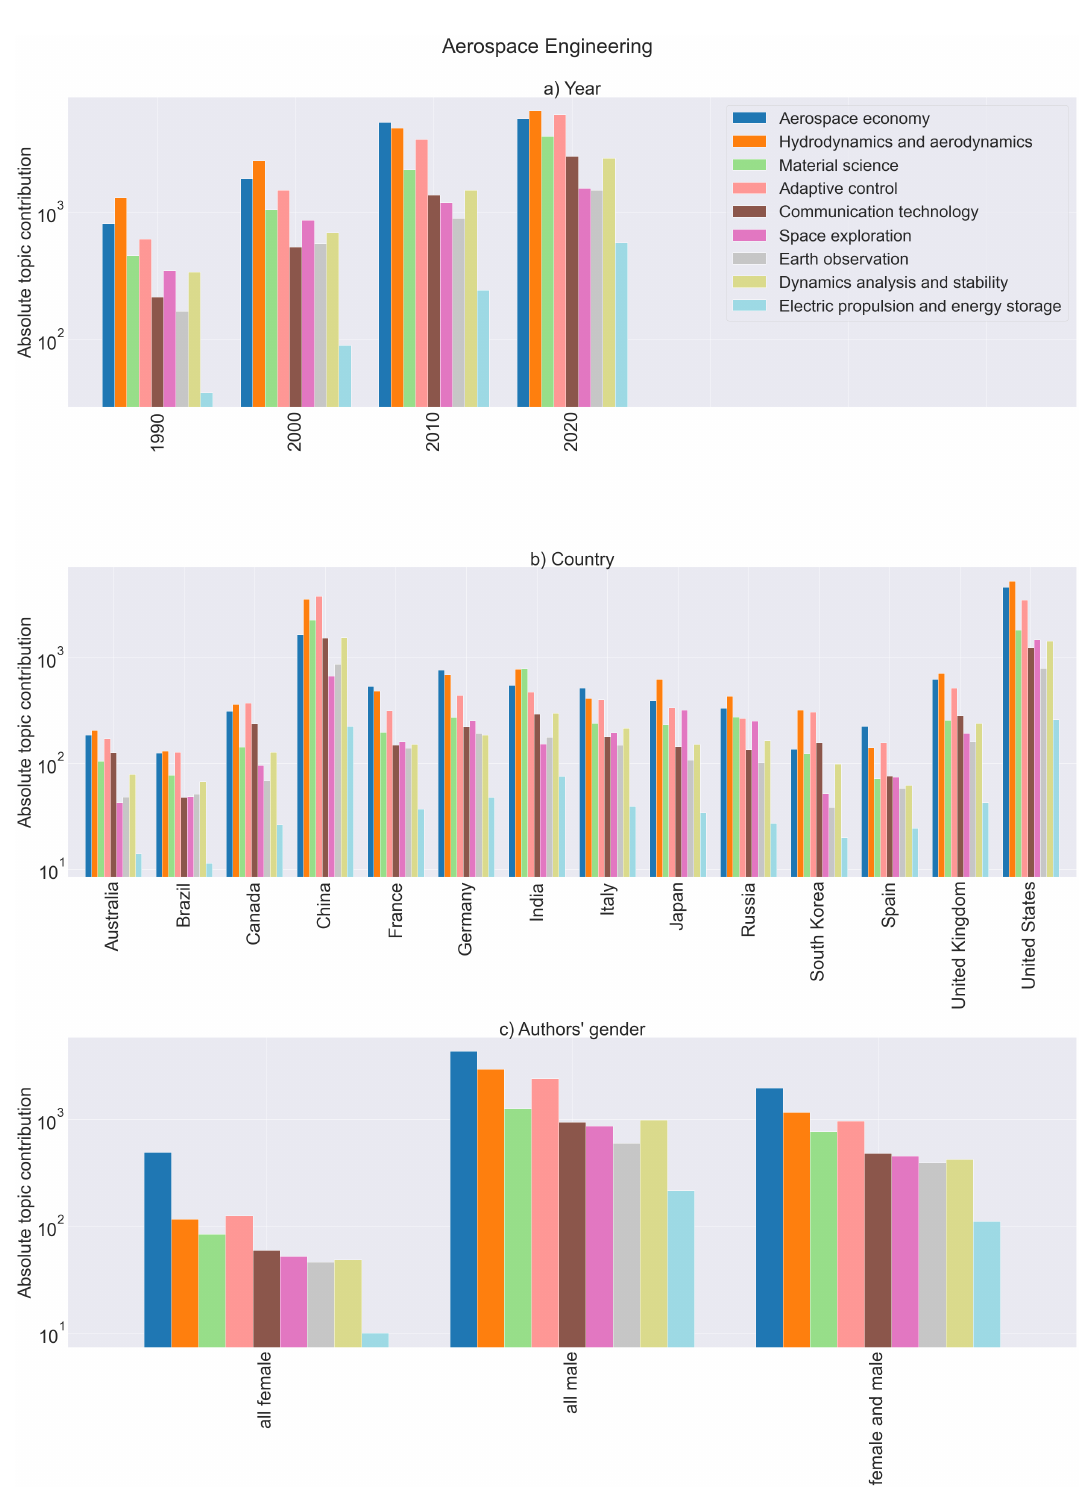
Figure 11. Absolute topic contribution (logarithmic scale on vertical axes), a κ ( ˆ D α ) , for 9 topics of the sub-area aerospace engineering grouped by ( a ) publication year, ( b ) country, and ( c ) authors’ gender. However, one observation regarding the absolute topic contributions is